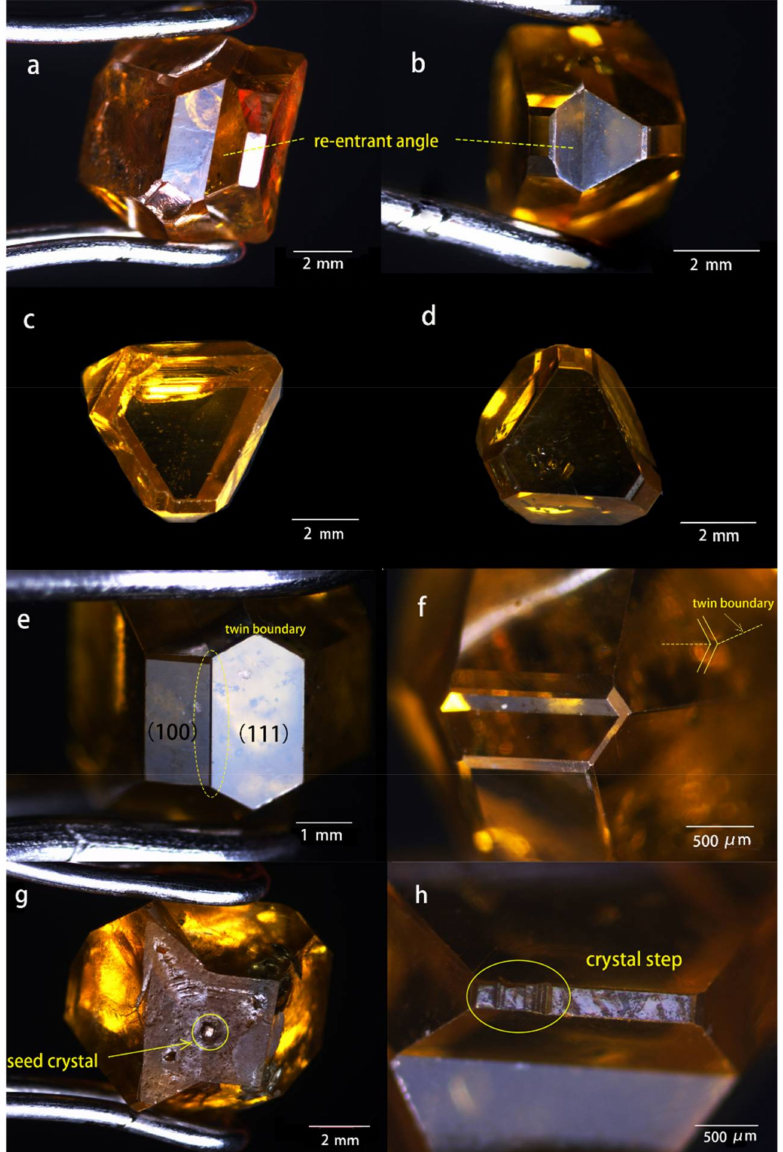
Figure 2. Macroscopic morphology of HPHT synthetic diamond with contact twinning: ( a , b ) the features of the re-entrant angle in TW-01 and TW-02; ( c , d ) the crystal morphology of TW-02 and TW-04, which are similar to the octahedral Macle of a natural diamond; ( e , f ) the features of twin boundaries in TW-07 and TW-13; ( g ) seed crystal of TW-01; ( h ) the crystal steps in